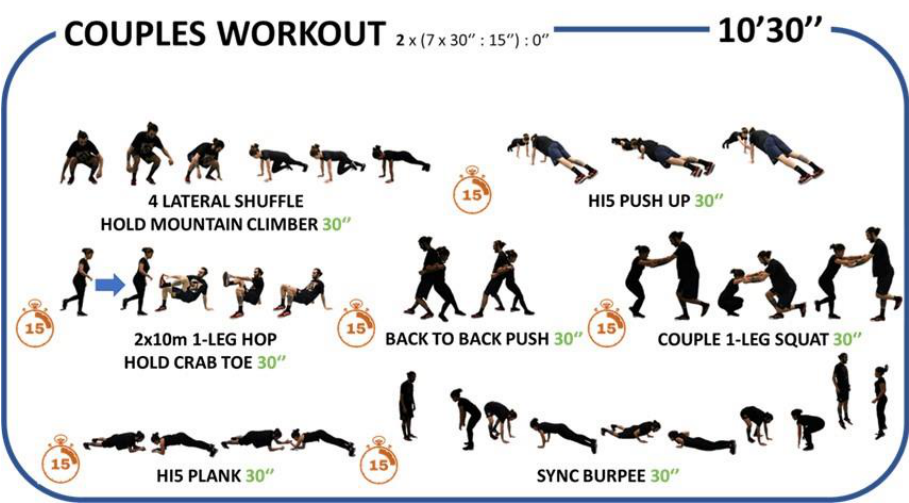
Figure 1. Graphical description of an example session (couples).